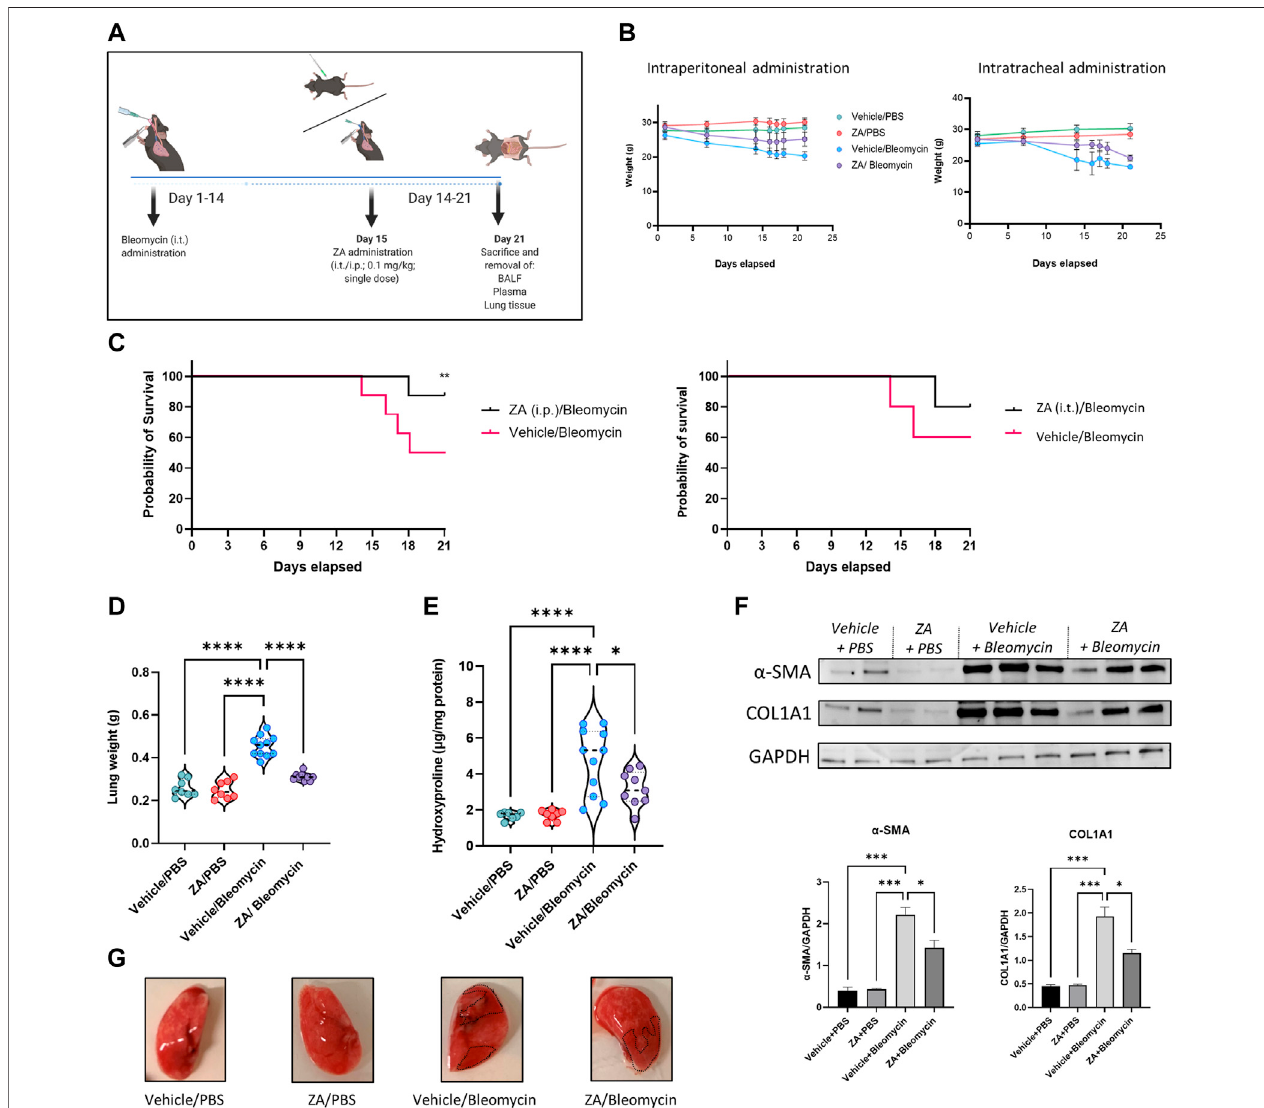
FIGURE 2 | ZA administration, murine weights, survival curve, and lung readouts. (A) ZA was administered intraperitoneally (i.p.) and intratracheally (i.t). on day 15 post-bleomycin introduction, with (B) murine total weight remaining stable in the ZA (i.p.) group for the duration of 21 days, with both bleomycin groups displaying signi fi cant weight loss after 14 days. (C) Resultant weight loss in the bleomycin/vehicle group caused signi fi cant mortality, with mice in the ZA/Bleo (i.p. and i. t.) groups seeminglyprotected. (D) Murinelungweightshowedsigni fi cantreductionsintheZAtreatedmicecomparedtothevehicle/bleomycingroup(drug-treatedsamples were compared to untreated control samples using a one-way ANOVA followed by a Dunnett ’ s post-hoc test: **** p < 0.0001). (E) Hydroxyproline collagen readout displayed signi fi cant reduction following ZA (i.p.) treatment (drug-treated samples were compared to untreated control samples using a one-way ANOVA followed by a Dunnett ’ spost-hoctest:**** p < 0.0001). (F) ImmunoblottingofZA-treatedmurinelunglysatesdisplayedsigni fi cantreductionsinboth α -SMAandCOL1A1comparedto bleomycinonly controllysates (G) Representativemurineimagesshowbleomycininducedlung damage(collagenousdepositionhighlightedindottedareas).Mice were allocated into groups as follows: Vehicle (i.p.)/phosphate buffered saline (PBS; i. t.); zoledronic acid (ZA; i. p.)/PBS (i.t.); Vehicle (i.p.)/Bleomycin (i.t.); ZA (i.p.)/ Bleomycin